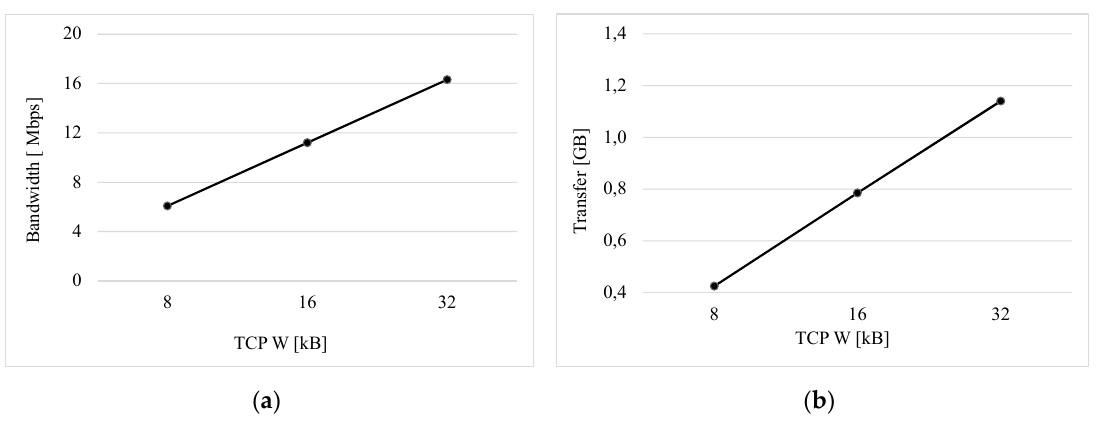
Figure 8. Dependency of TCP window length: ( a ) Network bandwidth; ( b ) Network transfer.